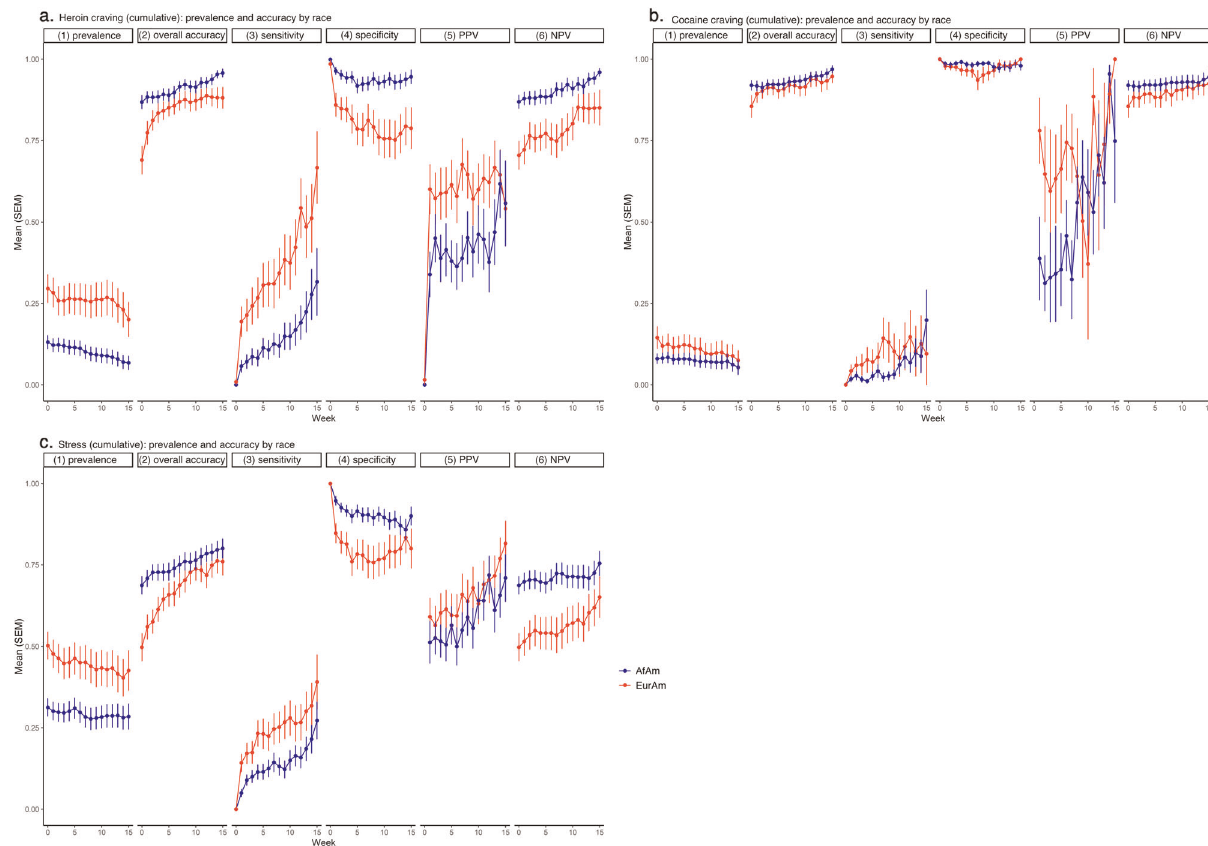
Fig. 5 Prediction accuracy (and prediction-target prevalence) per person per week, by race. a Heroin craving, b cocaine craving, and c stress. There were 120 African-American (AfAm) participants and 66 European-American (EurAm) participants. Details as in Fig.